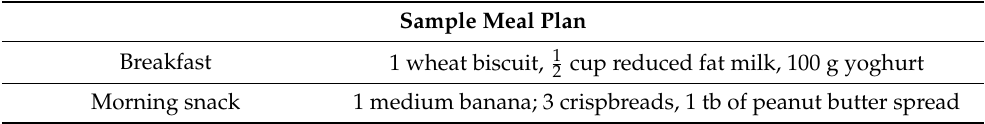
Table 4. Australian Dietary Guidelines sample meal plan and nutrient analysis for a 10-year- old